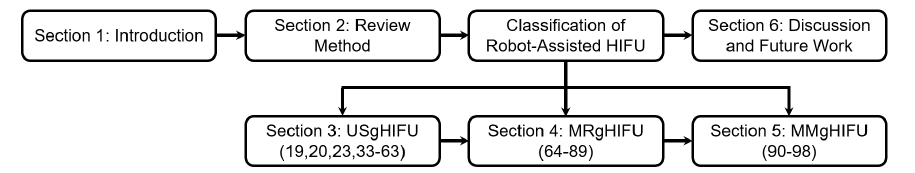
Figure 1. Outline of the review paper with corresponding